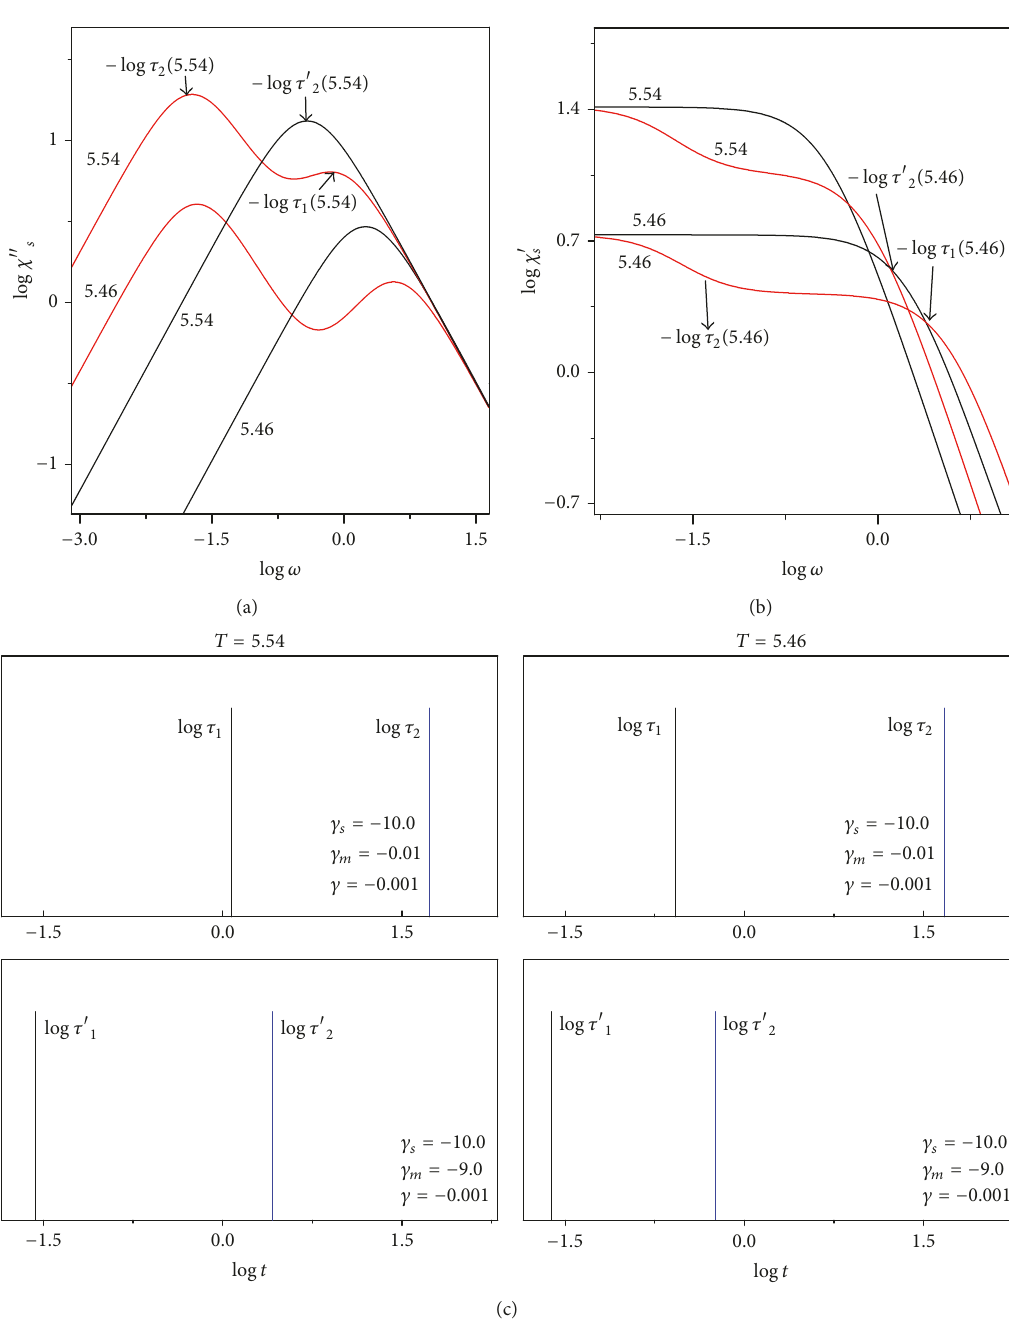
Figure 2: Double logarithmic plots of (a) the staggered magnetic absorption factor ( 𝜒 󸀠󸀠 𝑠 ) and (b) the staggered dispersion factor ( 𝜒 󸀠 𝑠 ) versus frequency of the staggered magnetic field for two different sets of Onsager’s rate coefficients (red lines for 𝛾 𝑠 = −10.0 , 𝛾 𝑚 = −0.01 , and 𝛾 = −0.001 ; black lines for 𝛾 = −10.0 , 𝛾 = −9.0 , and 𝛾 = −0.001 ) in the ferromagnetic phase. The number accompanying each curve is the 𝑠 𝑚 value of the reduced temperature. (c) The distributions of the two relaxation times of the metamagnetic Ising model for two different sets of = 1.0 and 𝑇 (1) = 5.563 Onsager’s rate coefficients. Here, 𝑟 = 1.0 and 𝐻 𝑟 𝑟 𝑁 𝑁